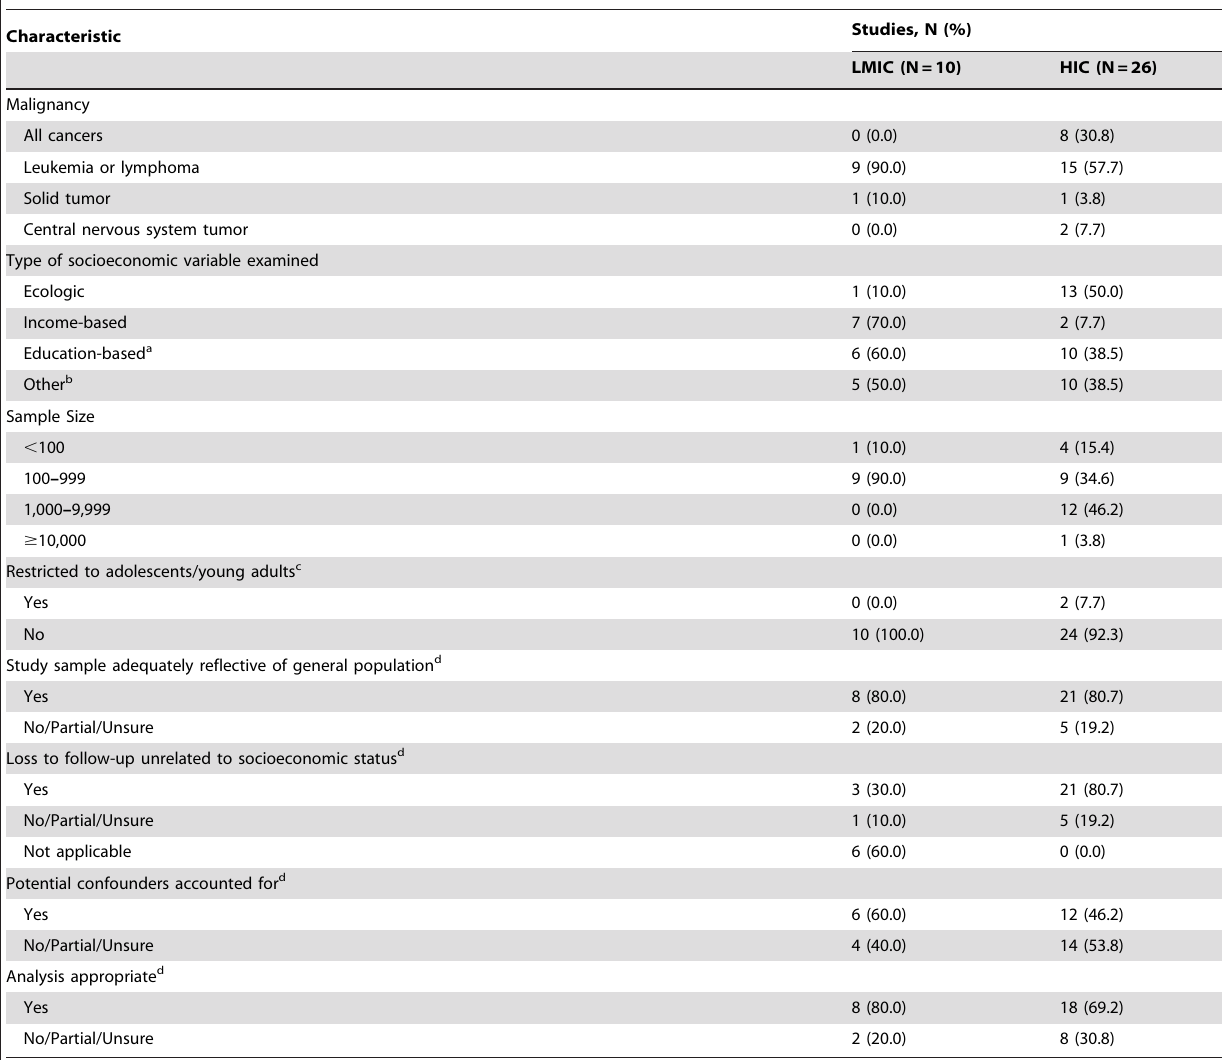
Table 2. Characteristics of included